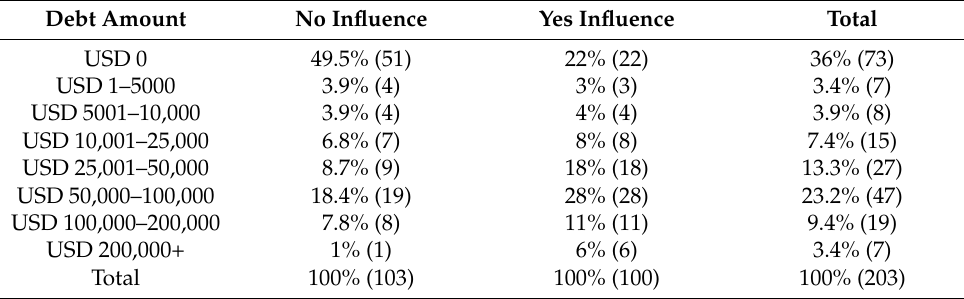
Table 4. The financing differences between debt career influence.